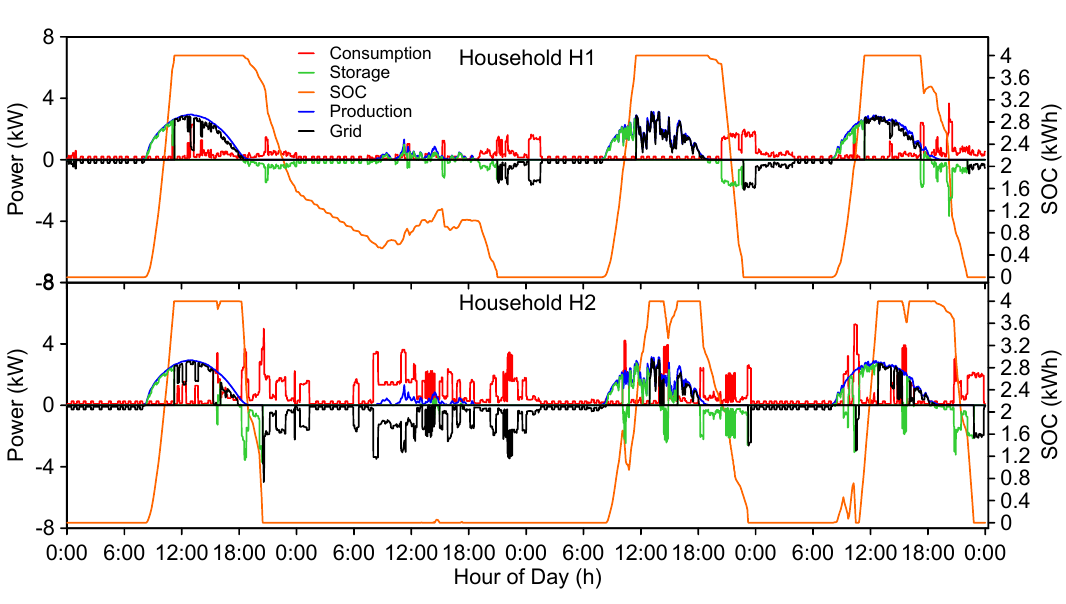
Figure 7. Individual results of two households with 3200 W of PV peak and 4000 Wh of energy storage installed. Simulation from 18 to 21 March with 1-min